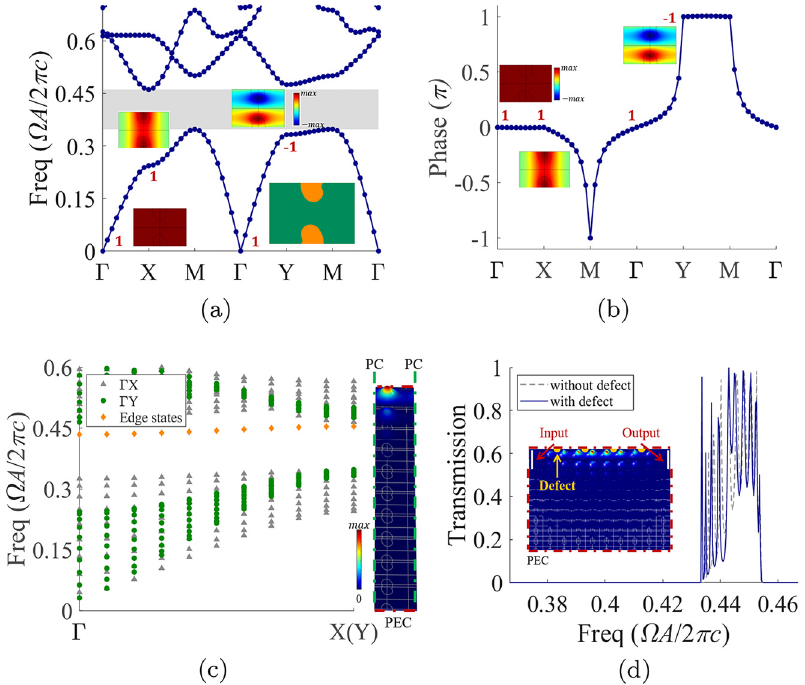
-symmetry. (a) The unit cell and its band structure. The inserted diagrams are the Figure 2: The optimized rectangular lattice with C 2 ( k ) of the 1st band; (c) the eigenstates at high-symmetry momenta, and markers ‘‘ ± 1’’ displayed their parities; (b) the phase diagram Φ m C 2 supercell’s band along Γ X (gray-triangle point) and Γ Y (green-circle point) with truncation (more detail of truncation refers to Appendix B), and edge state (along Γ X) denoted as a yellow-diamond point. The inserted eigenstate corresponds to the Γ X’s edge state of Γ point; (d) the transmission spectrum of edge states without and with defects, where defects are denoted as yellow semi-circles in the inserted full-wave simulation result. Periodic condition is denoted as PC with green dashed line in Figure 2(c); all free boundaries (i.e., the red dash-dot lines unless otherwise stated) for TM wave are set as perfect electric conductor (PEC) in Figure 2(c) and